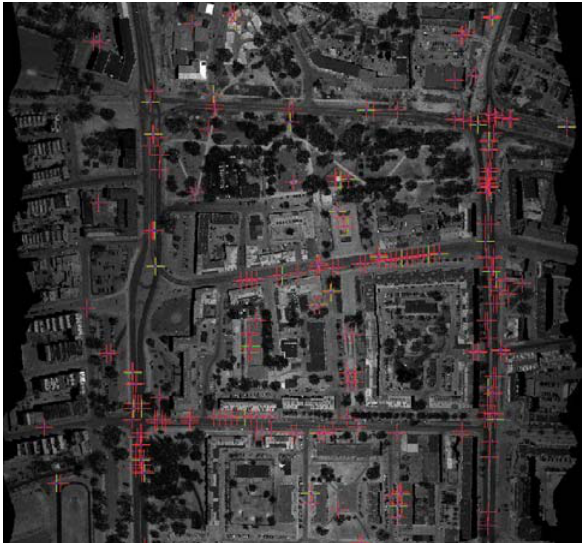
Figure 2. Spatial distribution of points measured on intensity image and